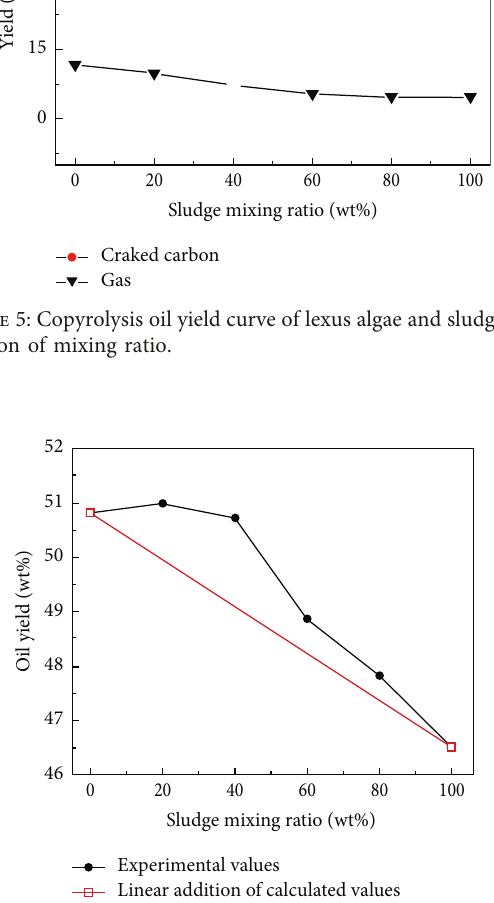
Figure 6: Changes in gas and solid two-phase products of copy- rolysis of foxtail algae and sludge with the mixing